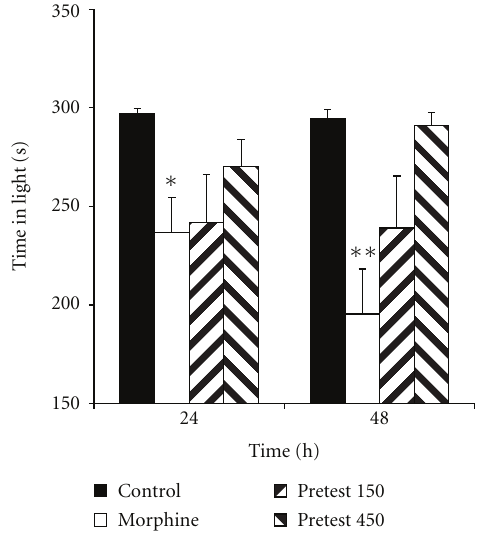
Figure 3: The e ff ects of pretraining injection of sa ff ron extract on the total time spent in the light compartment 24 and 48h after receiving the shock between the groups. The animals of control group received saline instead of both sa ff ron extract and morphine. The animals of morphine group were treated by saline instead of SE but received morphine (5 mg/kg, s.c.) 30 min before the training phase. Pretrain 50, pretrain 150, and pretrain 450 groups were treated by 50, 150, and 450 mg/kg of SE (i.p.), respectively, for 3 days before the training phase. The data were presented as mean ± SEM of the total time spent in the light compartment (8 animals in each group). ∗ P < 0 . 05 and ∗∗ P < 0 . 01 compared to control; + P < 0 . 05 compared to morphine group.